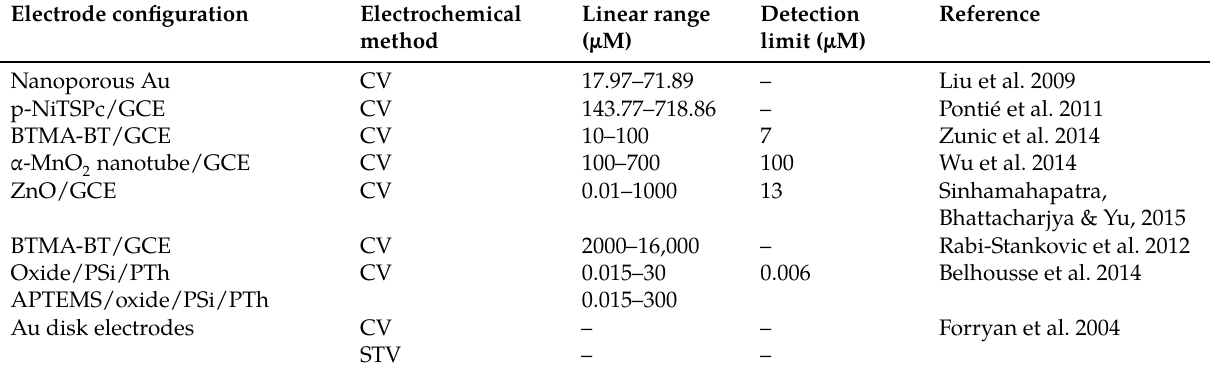
Table 1: Summary of the determination of p -NP at unmodified and modified